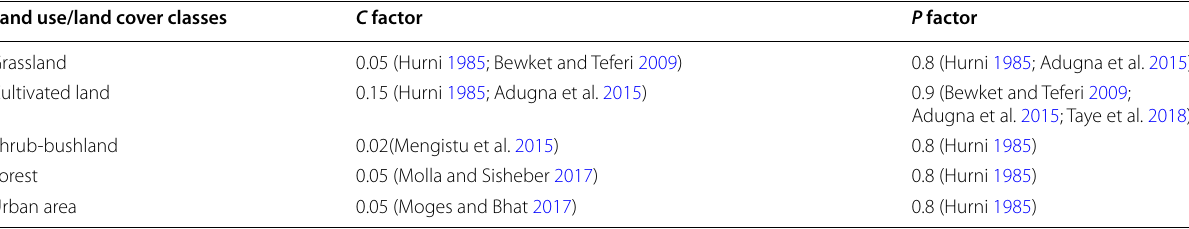
Table 6 C -factor and P -factor values for the respective land use/land cover classes of Muga watershed, Upper Blue Nile Basin, Ethiopia Land use/land cover